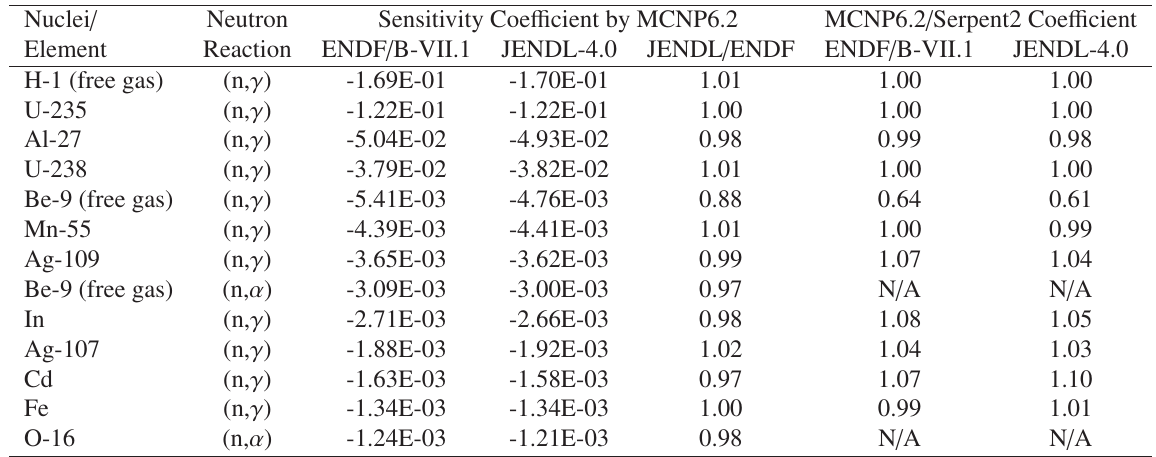
Table 1. Design Parameters of RSG GAS [1]